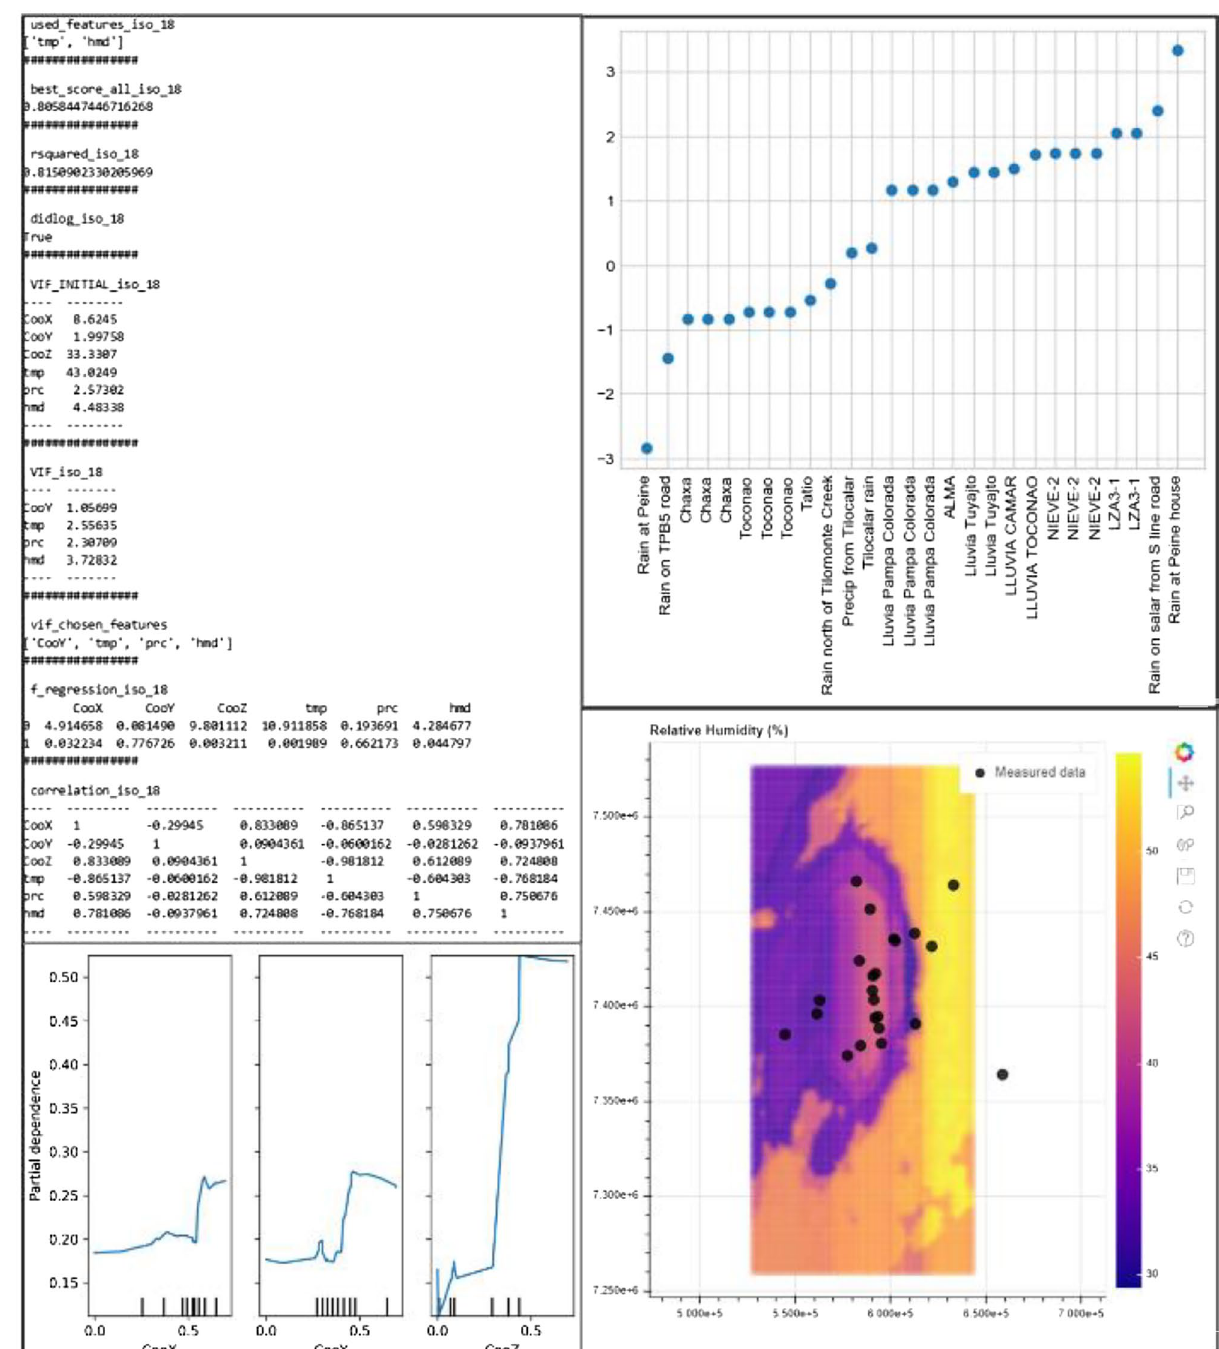
Figure 8. Screenshots of the outputs generated by Isocompy. Top left: an example report. Bottom left: partial dependency plots of the selected features. The values are standardized between zero and one. Vertical ticks on the x-axis illustrate the percentile of the data. Top right: a residual plot at each observation point generated by Isocompy via the isotope_meteoline_plot method. Bottom right: an interactive map generated by Isocompy without an available shape